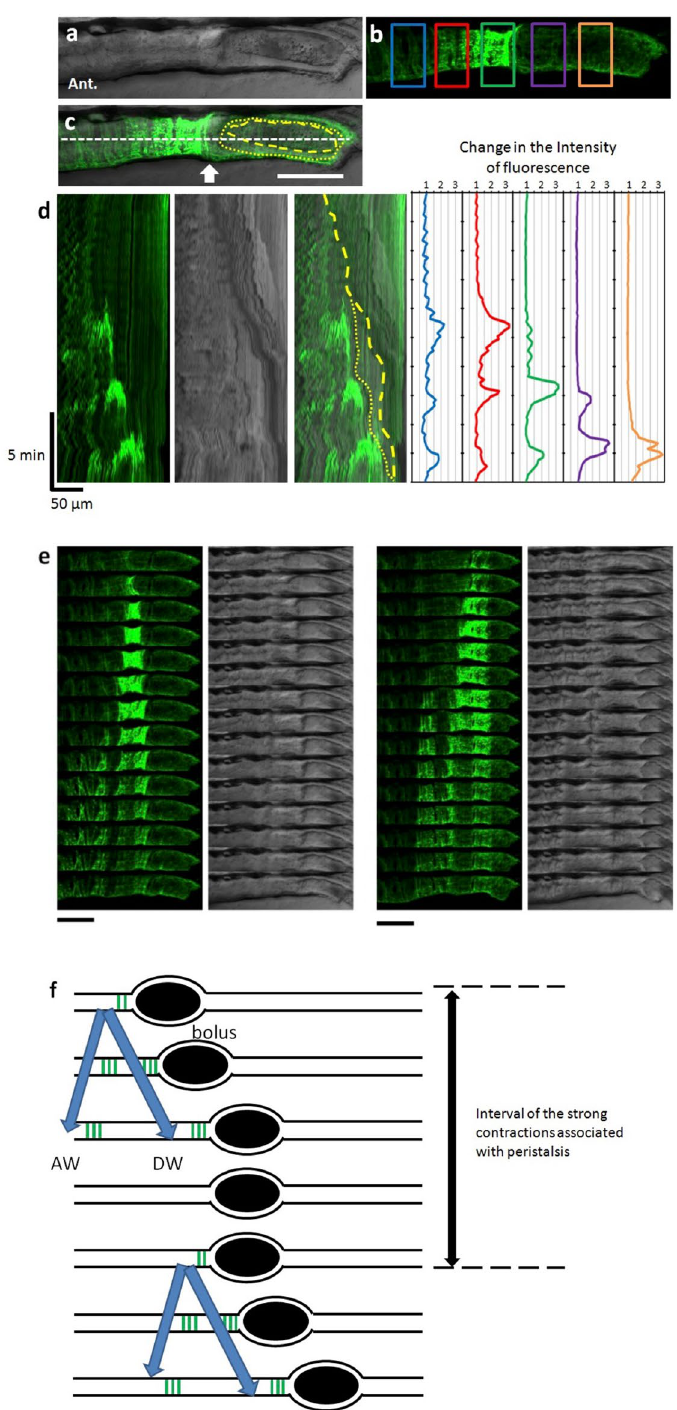
Figure 2. Peristaltic reflex visualized by Ca 2+ imaging of circular smooth muscles. ( a–c ) Live confocal image of the lateral view of SAGFF(LF)134A; Tg(UAS: GCaMP3) at 8 dpf. Bright field image ( a ), GCaMP3 fluorescence (green) ( b ), and merged image ( c ). In ( b ), measurement locations are shown in rectangles. In ( c ), the yellow dashed line represents the outline of the bolus. The yellow dotted line represents the outline of the liquid surrounding the bolus. Scale bar, 50 μm. ( d ) Kymograph of GCaMP3 fluorescence, bright field image and merged image at the site noted by the white dashed line in ( c ), and time course of the fluorescence intensity at each site noted by the five squares in ( b ). ( e ) Time-lapse series of the second (left) and third (right) events in ( d ). Scale bars, 50 μm. Interval, 11 s. ( f ) Schematic diagrams showing Ca 2+ events in the circular muscles at the peristaltic movement. Black ellipses denote bolus. Also see Supplementary video